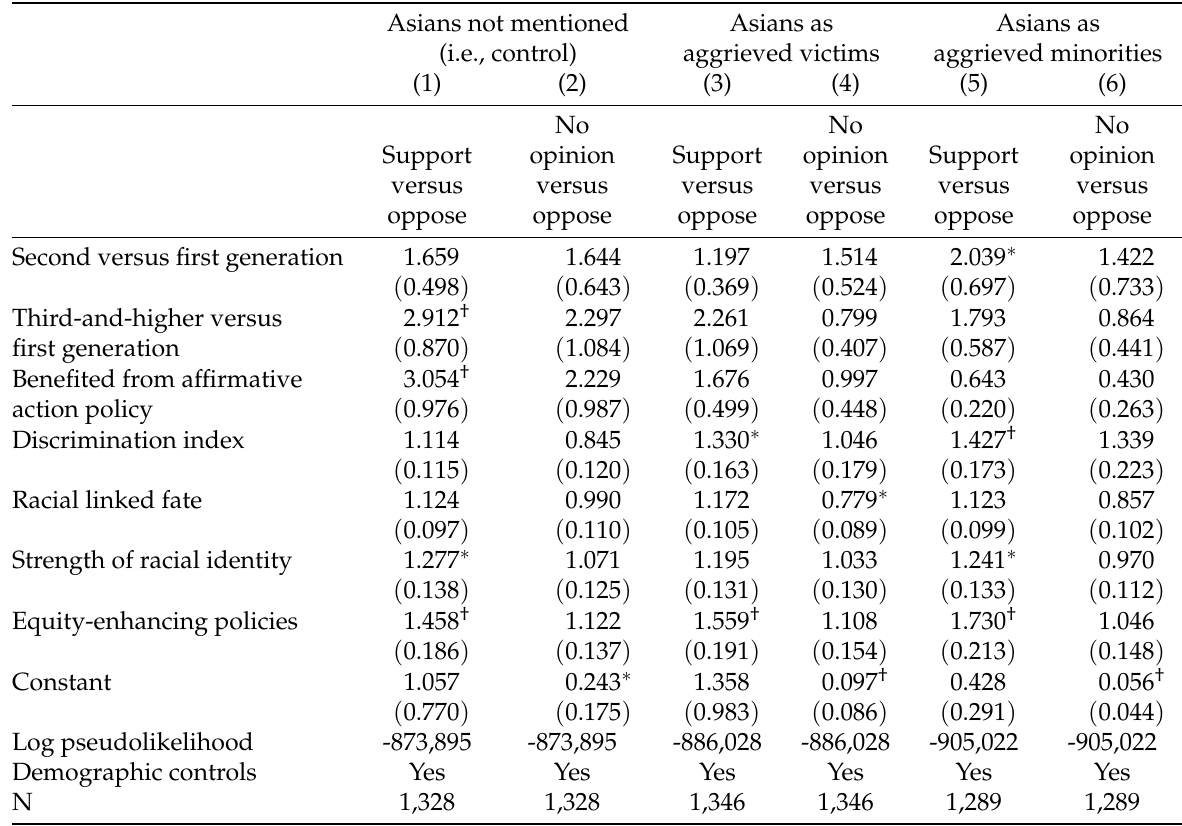
Table 3: Selected variables from multinomial logistic regressions on preference for hiring and promotion by frame, Asian respondents only. Source: 2016 National Asian American